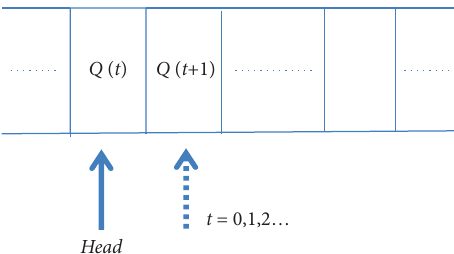
Figure 5: Remove team head elements and reconstruct solution system.